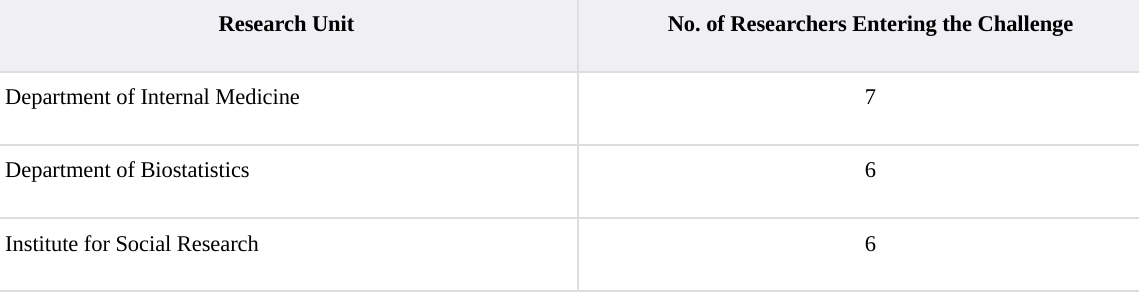
Table 1. A list of University of Michigan academic units that had at least one researcher who participated in the Reproducibility